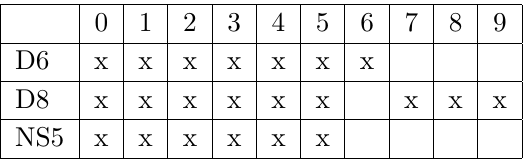
Table 2 . 1 -BPS brane intersection underlying the 6d (1,0) CFTs dual to the AdS 7 solutions 4 in [36]. ( x 0 ; : : : ; x 5 ) are the directions where the 6d CFT lives, x 6 is the direction along which the NS5-branes are located, and ( x 7 ; x 8 ; x 9 ) realise the SU(2) R-symmetry of the internal